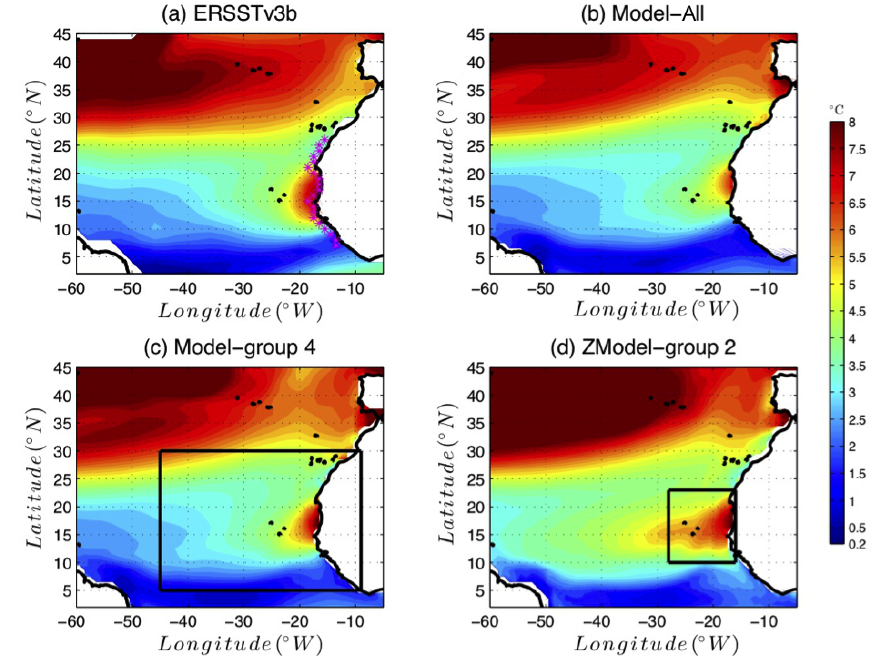
Figure 10. Amplitude of the SST seasonal cycle in (a) ERSSTv3b observations (b) Model-All, (c) Model-group 4 (best model group for the extended area, illustrated by the black rectangular box) and (d) ZModel-group 2 (best model group for the reduced area, illustrated by the small black rectangular box). The SST seasonal cycle is computed over the period